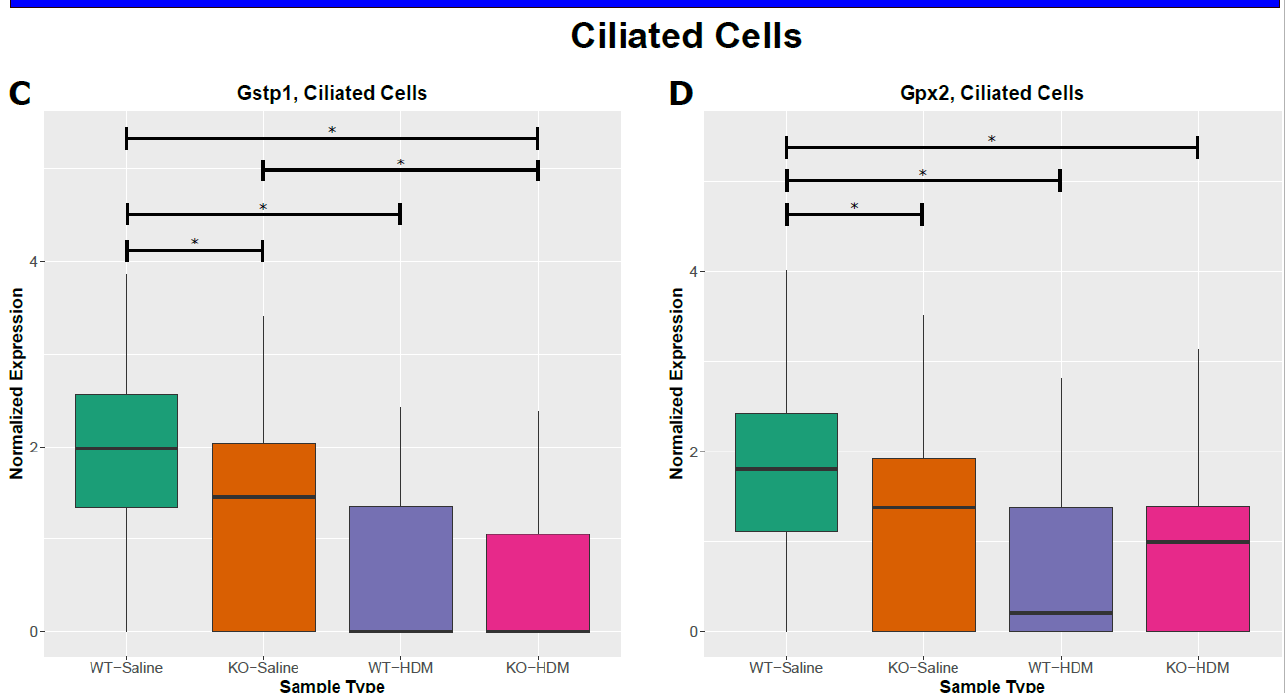
Figure 4. Cell-type specific changes resulting from HDM challenges and/or Tet1 deficiency. ( A , B ) AT2 cells; ( C , D ) ciliated cells. * represents FDR ≤ 0.05 Table 1. Number of differential expression genes (DEGs) of EpCAM + cells.